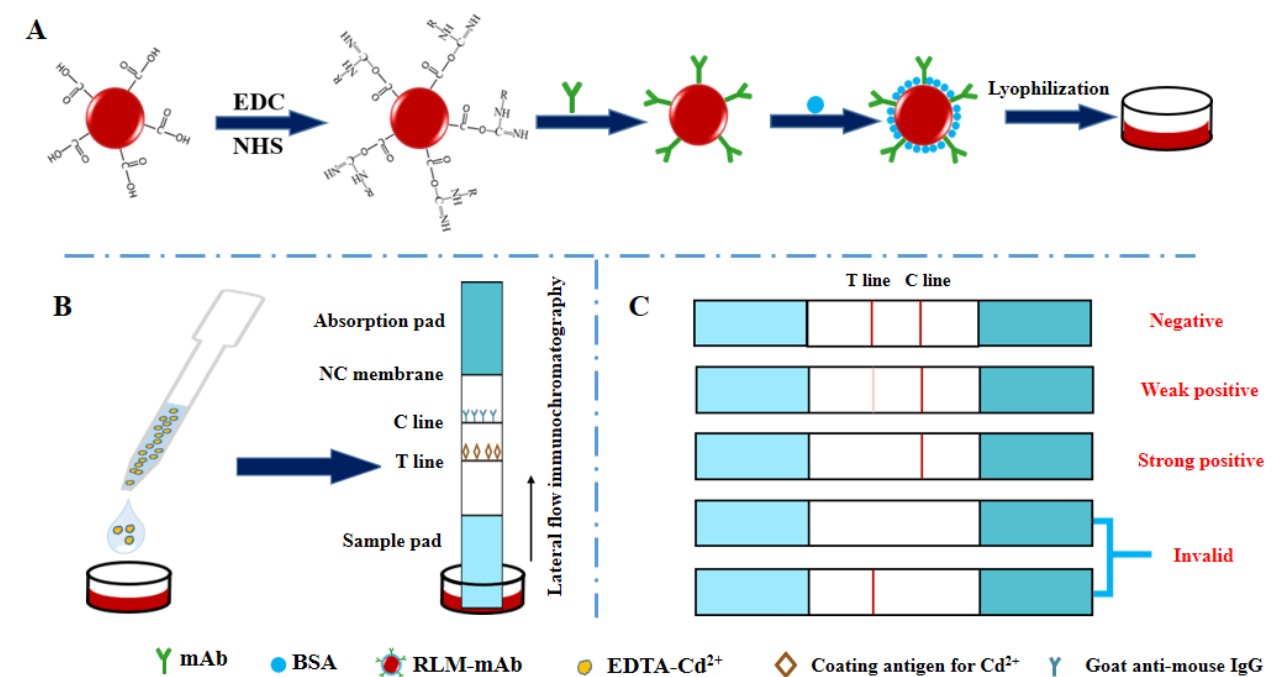
Figure 7. Schematic diagram of the preparation of immunochromatographic microsphere test strips for the Cd 2+ detection. ( A ) Probe preparation; ( B ) Operation of test strip; ( C ) Judgment of the result displayed by the test strip.